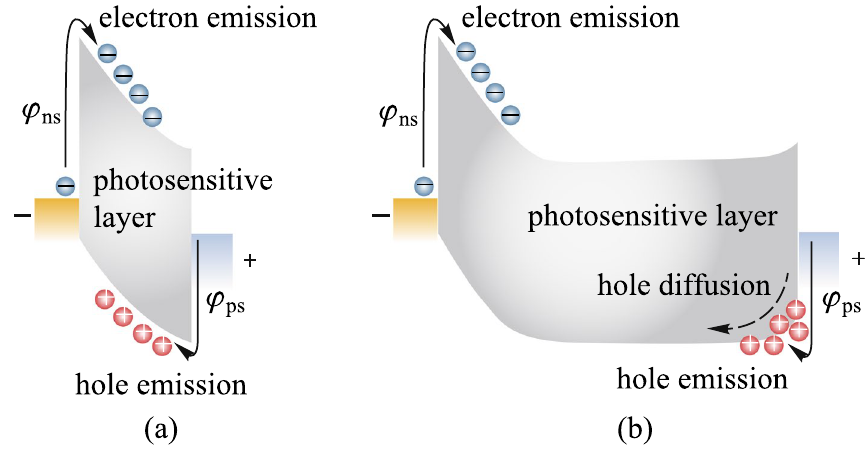
Fig. 2 Energy band diagrams of the Metal-Semiconductor-Metal (MSM) device with a thin and b thick photosensitive